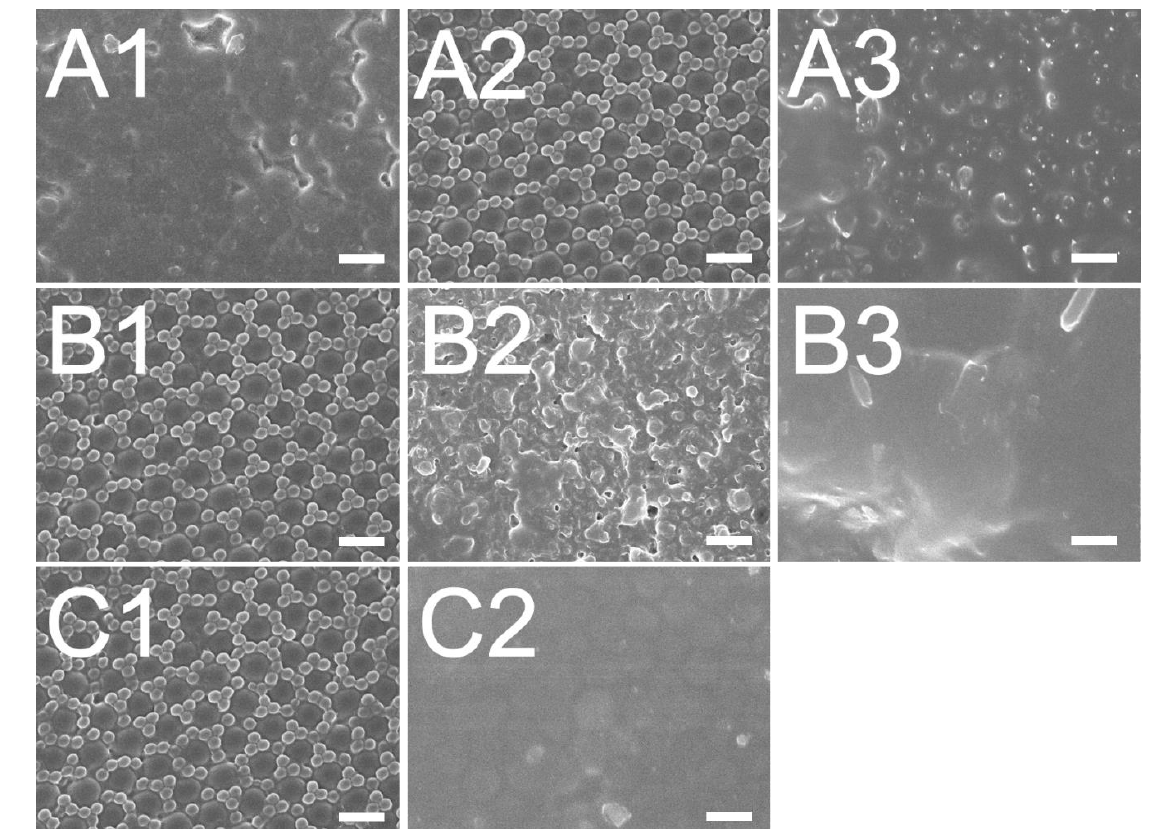
Figure 5. Influence of ( A ) distance between roller stamp and glass substrate; ( A1 ): +100 μm, ( A2 ): 0 μm, ( A3 ): −200 μm, ( B ) rolling speed; ( B1 ): 5.23 mm/s, ( B2 ): 13.08 mm/s, ( B3 ): 20.93 mm/s, ( C ) UV amount; ( C1 ):3900 mW/cm 2 , ( C2 ): 530 mW/cm 2 , on the manufacture of 300 nm/900 nm binary nanostructured films. (Scale bar: 1 μm).